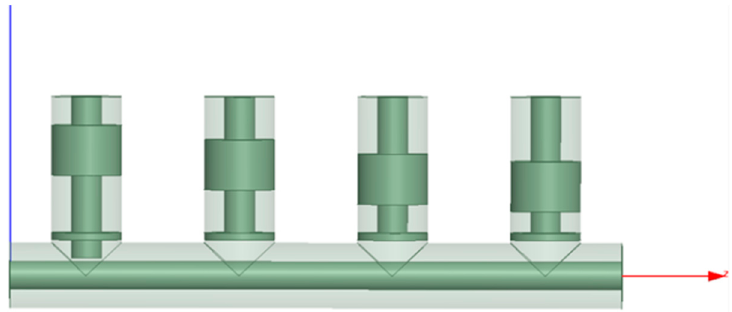
Figure 11. Schematic model design of the designed microwave equalizer structure.